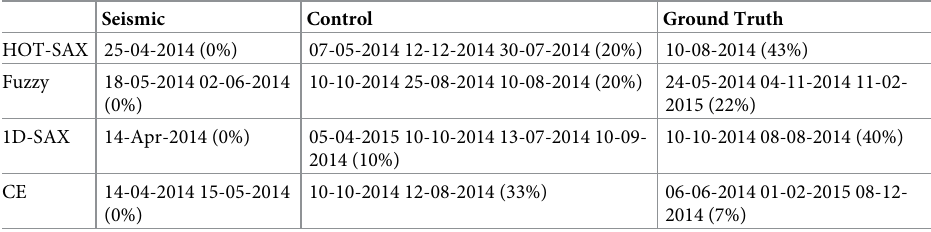
Table 6. Swarm C Grid 5 Ludian, experimental results.